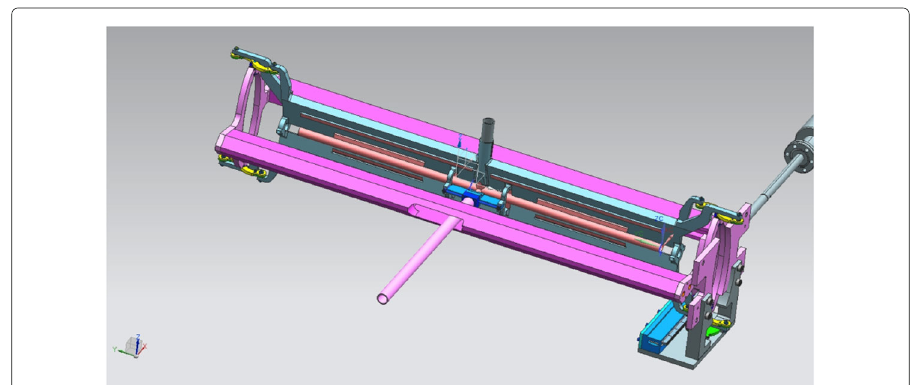
Fig. 14 Storage cell in the closed position. The polarized atomic beam is injected into the cell through a tube in the upper part of the cell (blue color), while a sample of the target gas diffuses into the direction of the BRP system through a side tube (pink color)